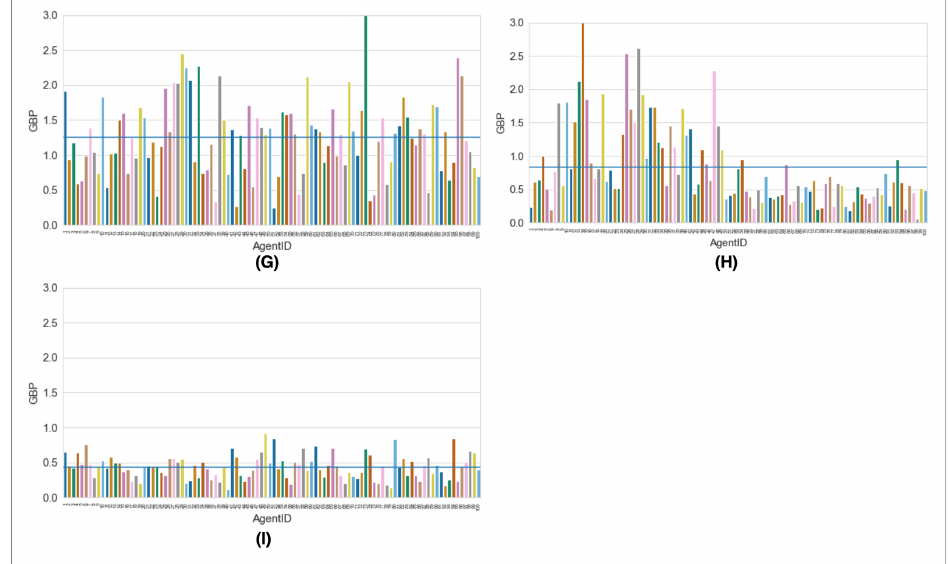
Figure A5. The total sum of petrol costs (GBP) for each ICEV, model conditions 7 to 9. Where ( G ): 100 vehicles, 100 non-adherence, ( H ): 100 vehicles, 50 non-adherence and ( I ): 100 vehicles, 0